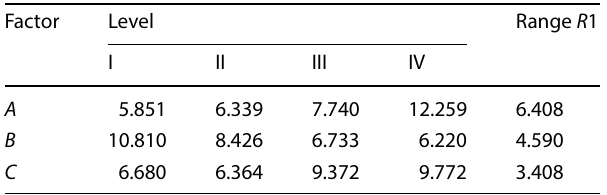
Table 3 Range analysis table for the float capture width ratio from the orthogonal test Factor Level